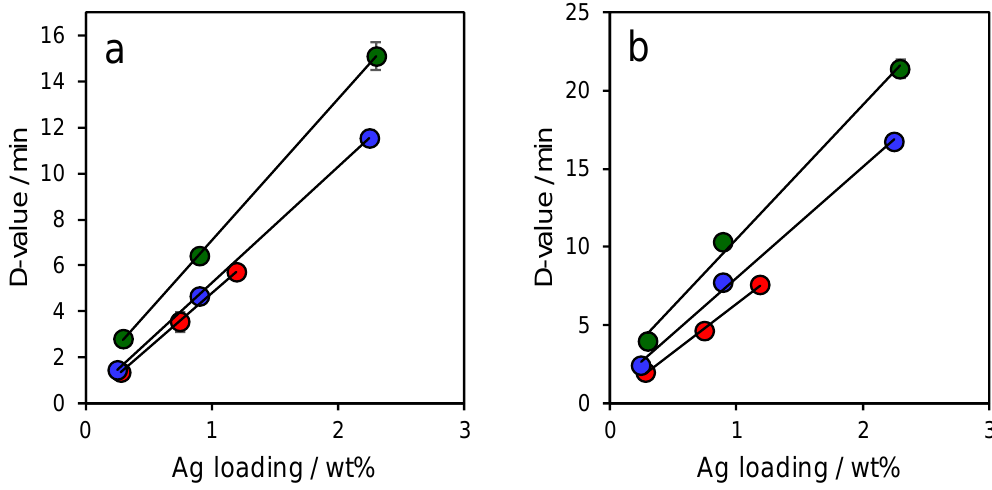
Figure 7. Decimal reduction times for Ag/TiO 2 /MM-SBA-15, Ag/TiO 2 /SBA-15 and Ag/SBA-15 against ( a ) Staphylococcus aureus , and ( b ) Pseudomonas aeruginosa.